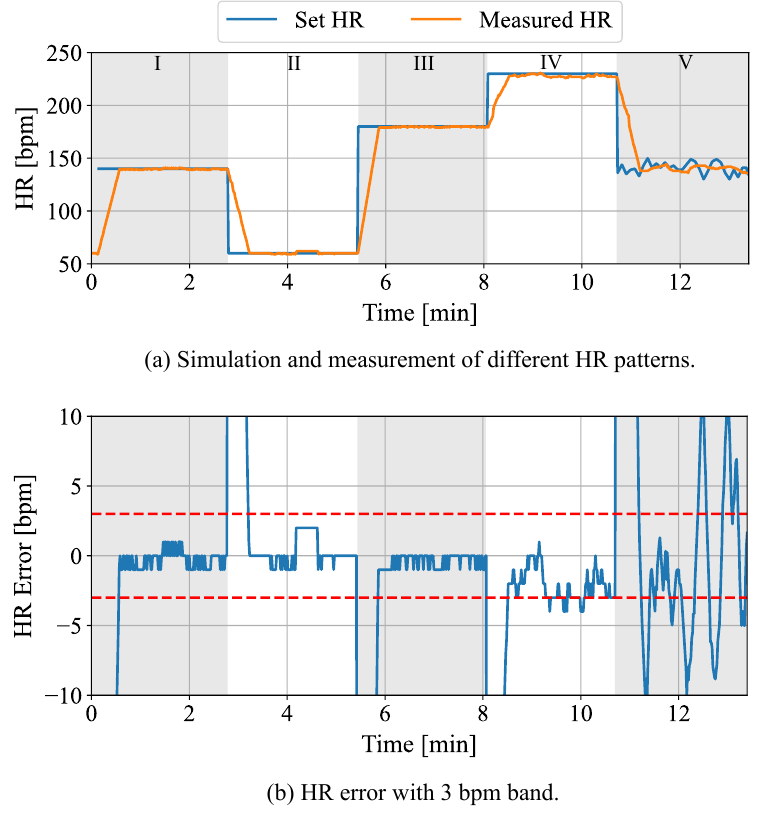
Figure 10. ( a ) Validation of HR detection and ( b ) the resulting measurement error. The dashed red lines in ( b ) show the 3bpm band. Table 6. Classification of HR simulation from Figure